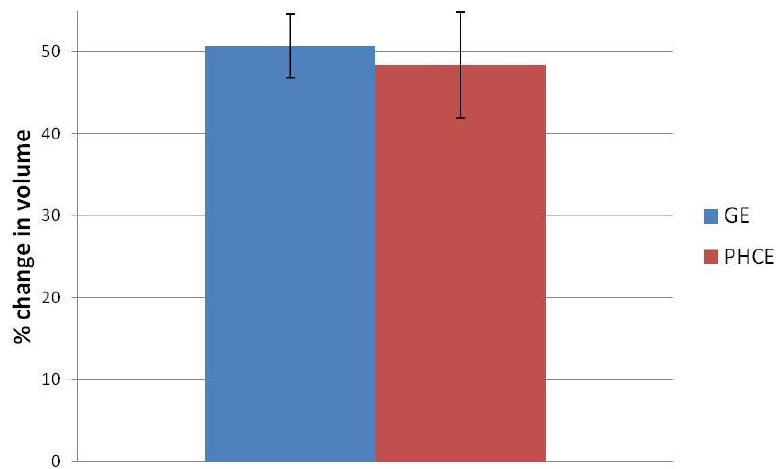
Figure 1. Swelling percentage of gelatin+EDC (GE) and PRGF+HA+CW+EDC (PHCE) scaffolds upon hydration. All scaffolds swelled up to approximately 50% of their original volume with no statistical difference between compositions.